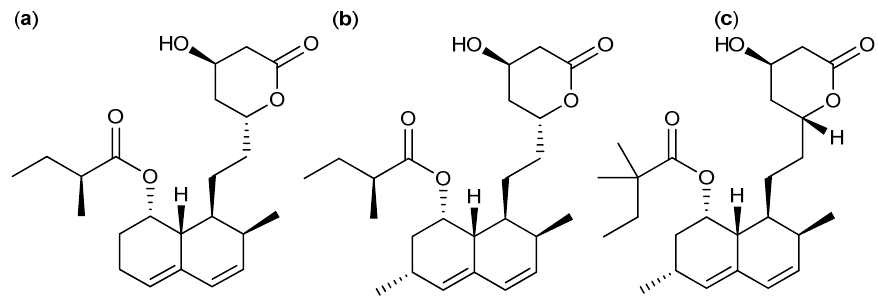
Figure 1. Statins: ( a ) Compactin, ( b ) Lovastatin and ( c ) Simvastatin.